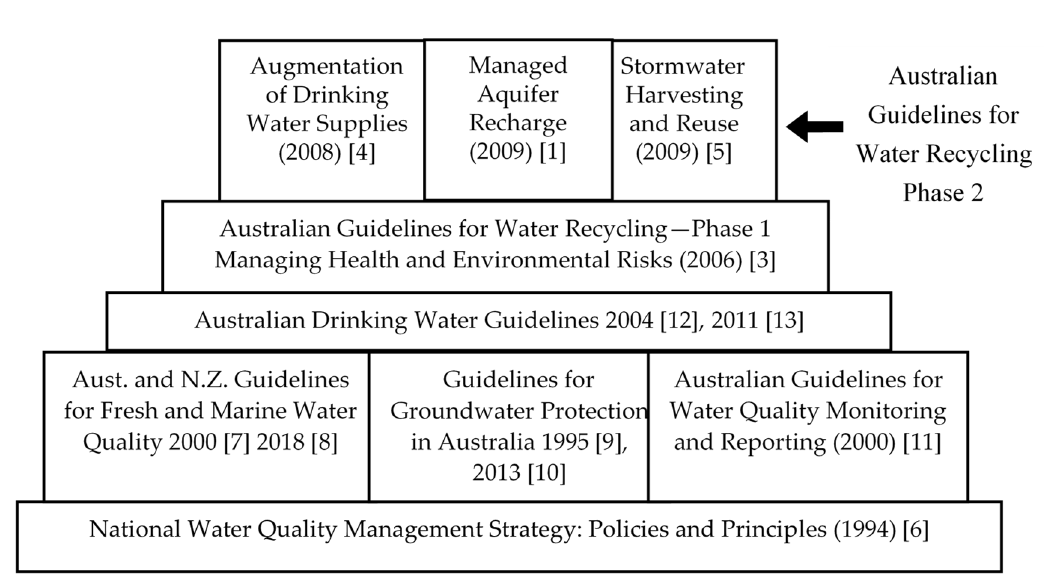
Figure 1. National Water Quality Management Strategy, showing the foundations for protecting human health and the environment, and innovation in Australian water management ([6] ARMCANZ-ANZECC (1994); [7] ANZECC–ARMCANZ (2000a), [8] WQA (2018); [9] ANZECC–ARMCANZ (1995); [10] WQA (2013); [11] ANZECC–ARMCANZ (2000b); [12] NHMRC–NRMMC (2004), [13] WQA (2011); Australian Water Recycling Guidelines - [3] NRMMC–EPHC–AHMC (2006); [4] NRMMC-EPHC–NHMRC (2008); [1] NRMMC-EPHC–NHMRC–(2009a); [5] NRMMC–EPHC–NHMRC (2009b)). Where Guidelines have been updated, both dates are given to show the evolution of guidelines but only the latter is applicable. All current guidelines are accessible from: https://www.waterquality.gov.au/guidelines.